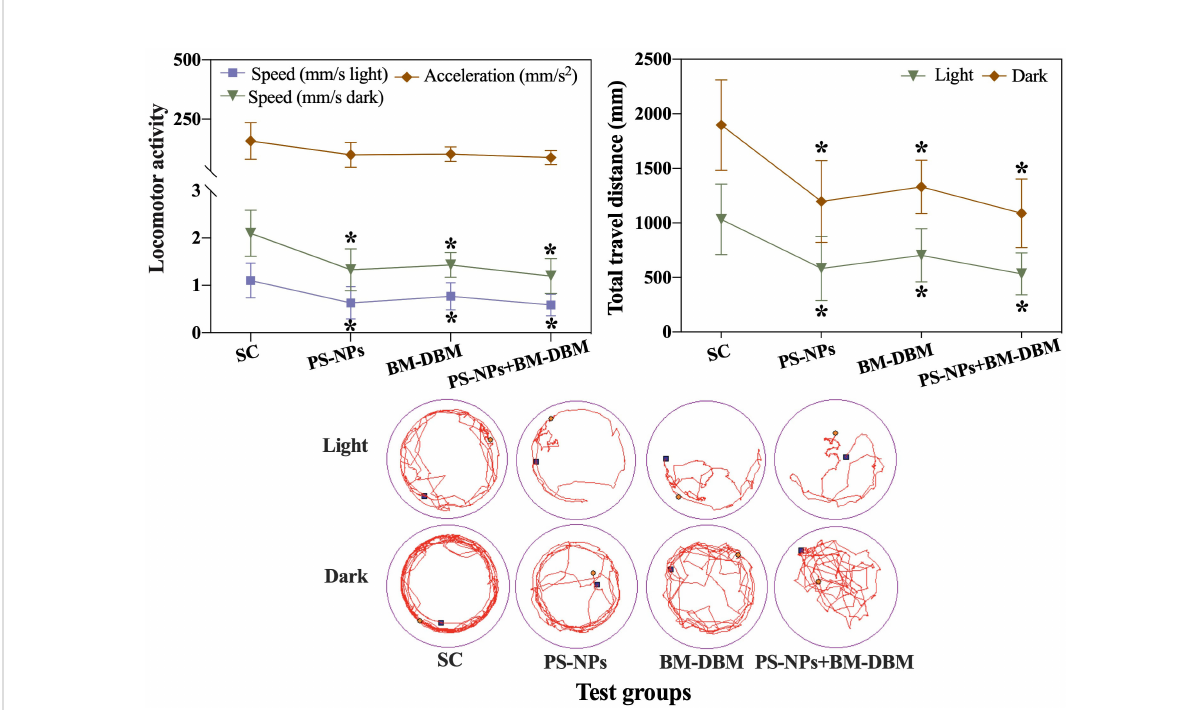
FIGURE 3 Behavioral response of 120 hpf zebra fi sh larvae exposed to BM-BDM and PS-NPs alone or in combination. SC represents the solvent control group. *indicates signi fi cant differences between the test group and the solvent control